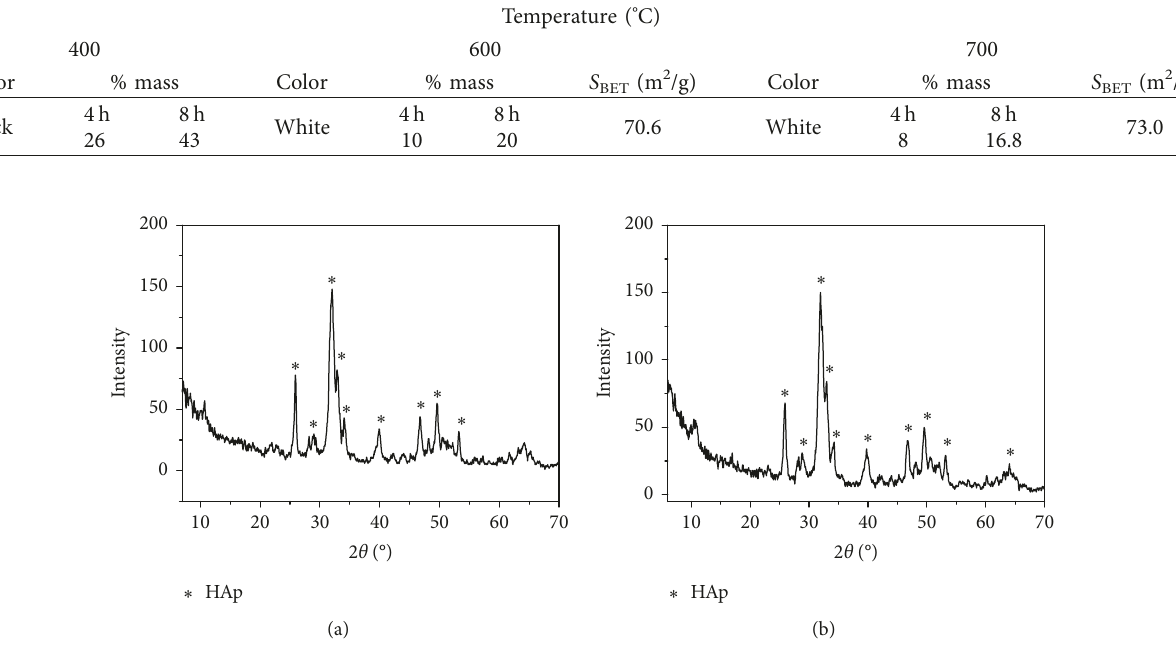
Figure 4: XRD patterns of H 3 granules sintered at (a) 600 ° C and (b) 700 ° C.